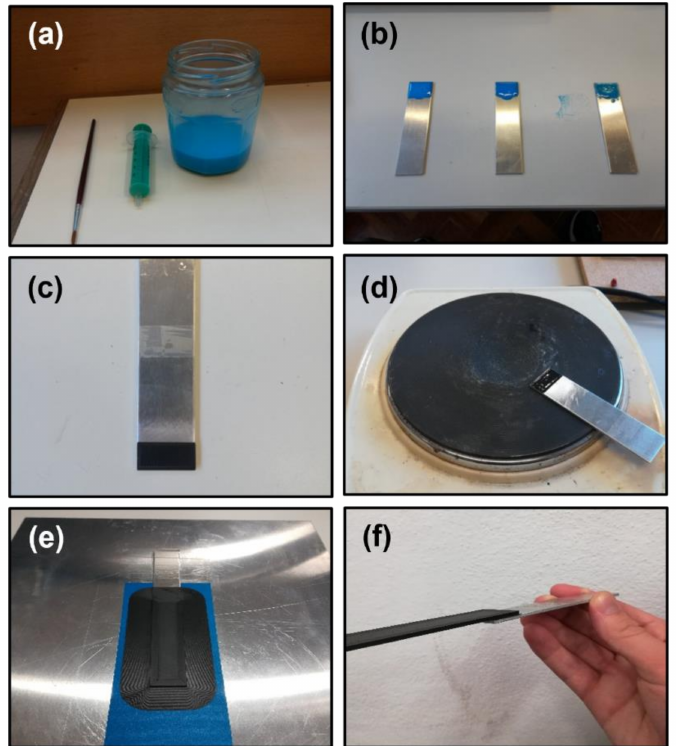
Figure 3. ( a ) ABS primer’s application tools; ( b ) three examples of base material with primer applied; ( c ) PA + CF specimen after the application of the primer by FFF; ( d ) remelting of the PA + CF primer on top of a hot plate; ( e ) aluminium–PA + CF single-lap joint resting time after 3D printing; and ( f ) aluminium-PA + CF single-lap joint after removal from the printer. Table 2. Single-lap joints results: filaments, surface treatments and primer. Filament Surface Treatment Primer Single-Lap Joint No SP ABS